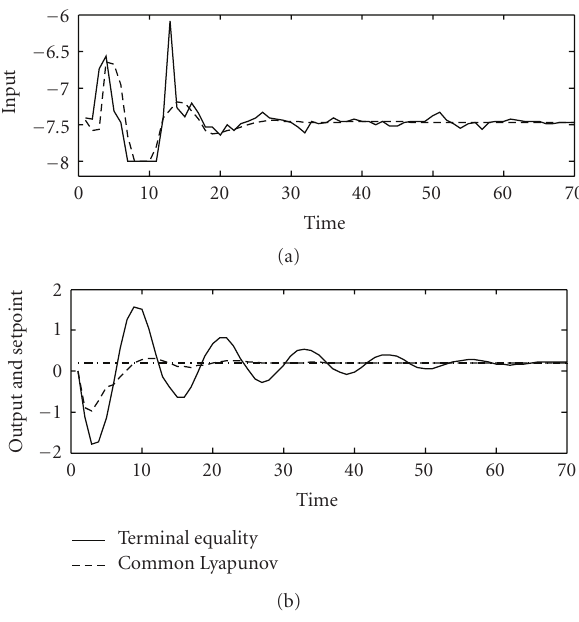
Figure 5: Comparison of the two Tracking RMPC